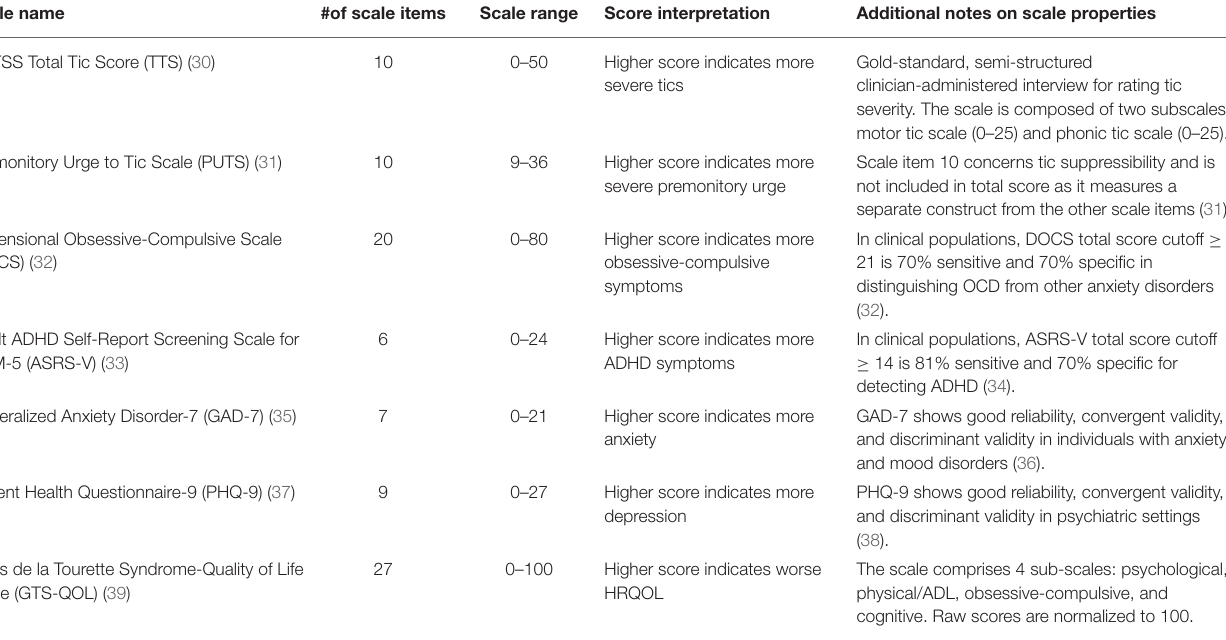
TABLE 1 | Clinical rating